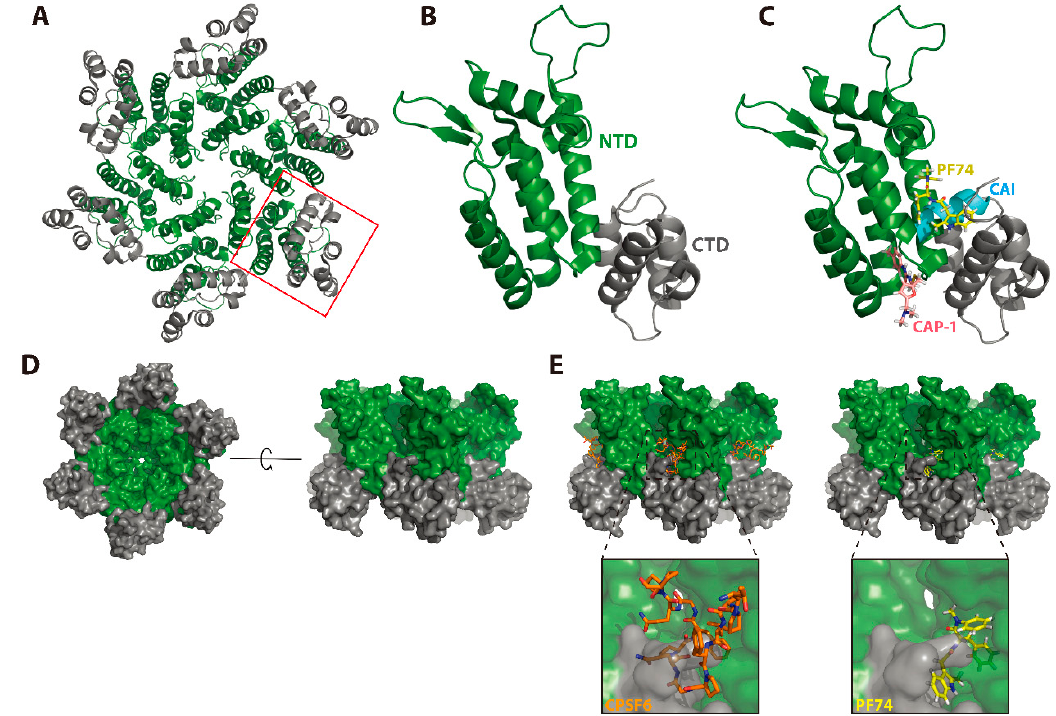
Figure 7. PF74 and other inhibitors perturb the CA-NTD / CA-CTD CA interface. ( A , B ) The intermolecular CA-NTD / CA-CTD interface (red box) contains key interactions stabilizing individual CA